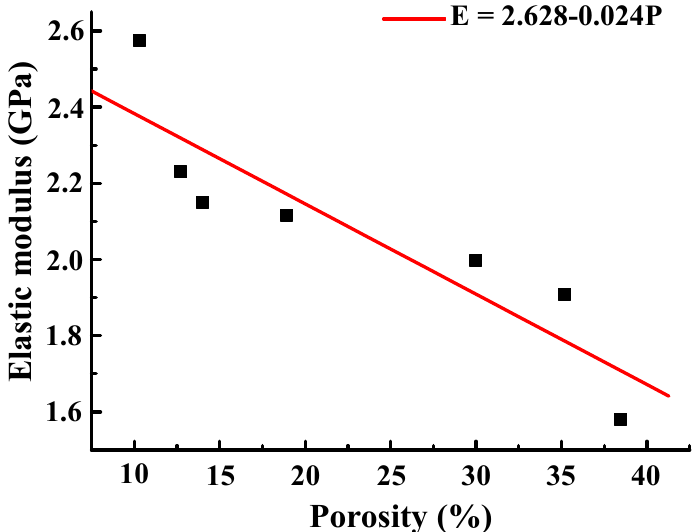
Figure 3. The linear regression model is the relationship between the porosity and the elastic modulus of the knitted BSCs.